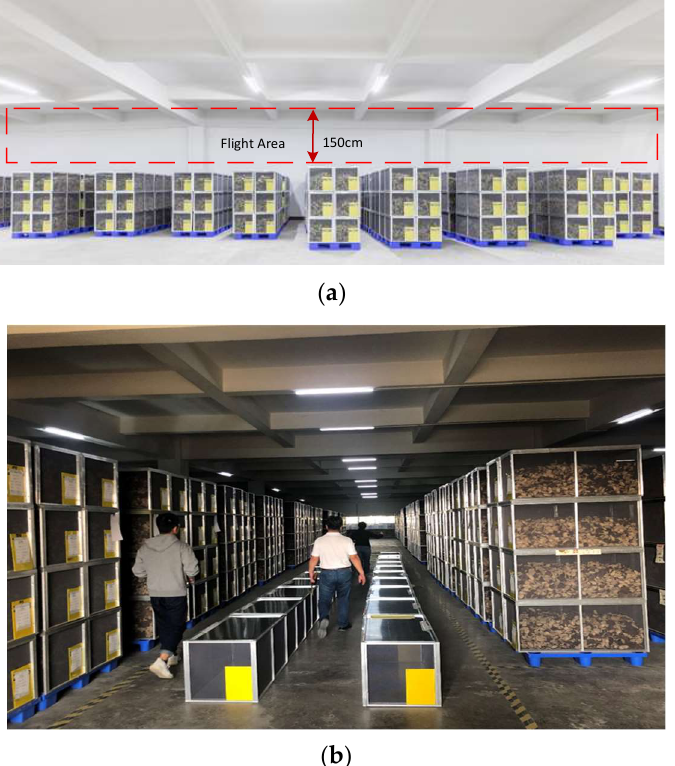
Figure 3. ( a ) Actual view of PCRC warehouse (flight safety distance); and ( b ) Actual view of PCRC warehouse (dark environment).